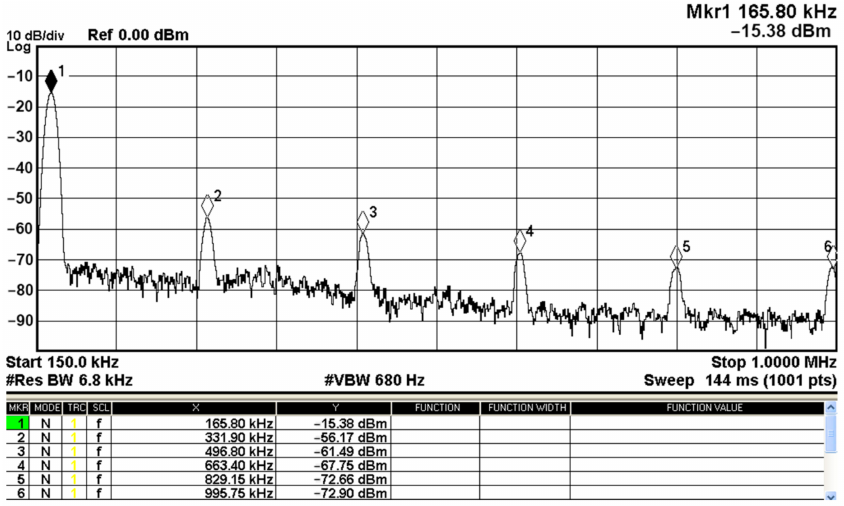
Figure 15. The frequency spectrum results of the NBPF at the output of V BP2 .